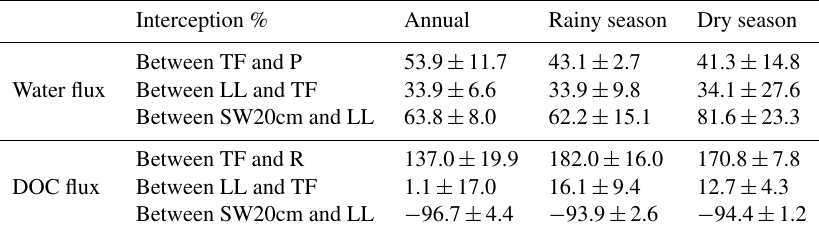
Table 1. The interception rate of the water between hydrological processes in the tropical rainforest at Xishuangbanna, south-west China.